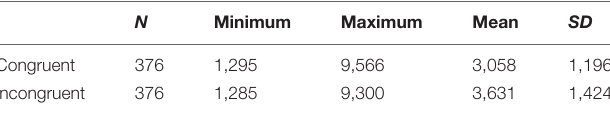
TABLE 1 | Response times for correct answers in